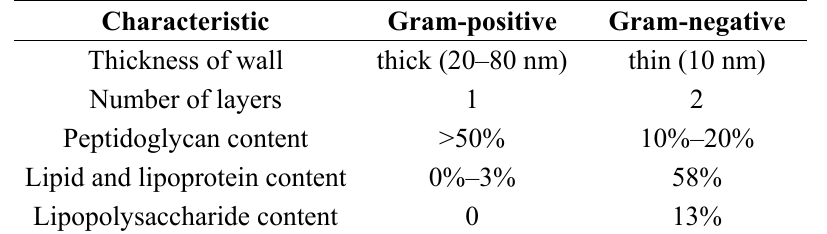
Table 1. Comparative characteristics of gram-positive and gram-negative